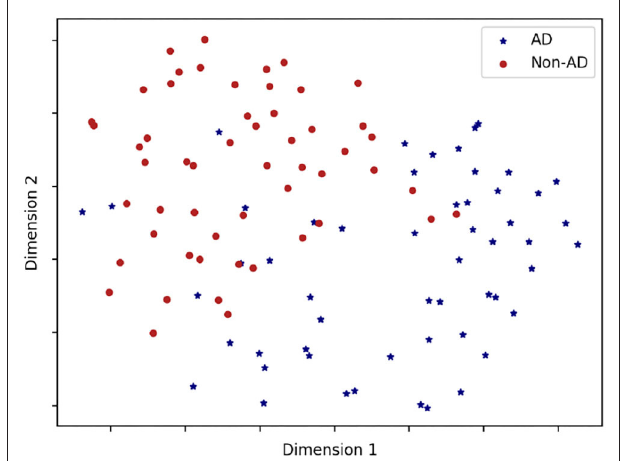
FIGURE 1 | A t-SNE plot showing class separation. Note we only use the 13 features significantly different between classes (see Table 10 ) in feature representation for this